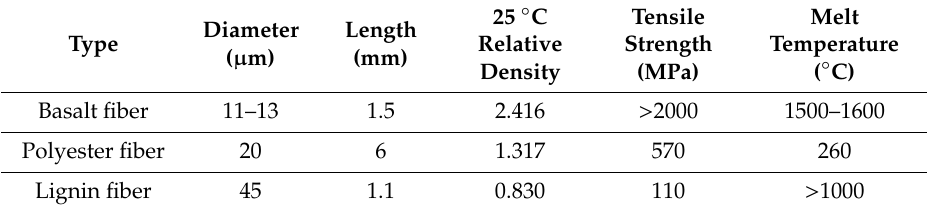
Table 5. Main characteristics of basalt fiber, polyester fiber and lignin